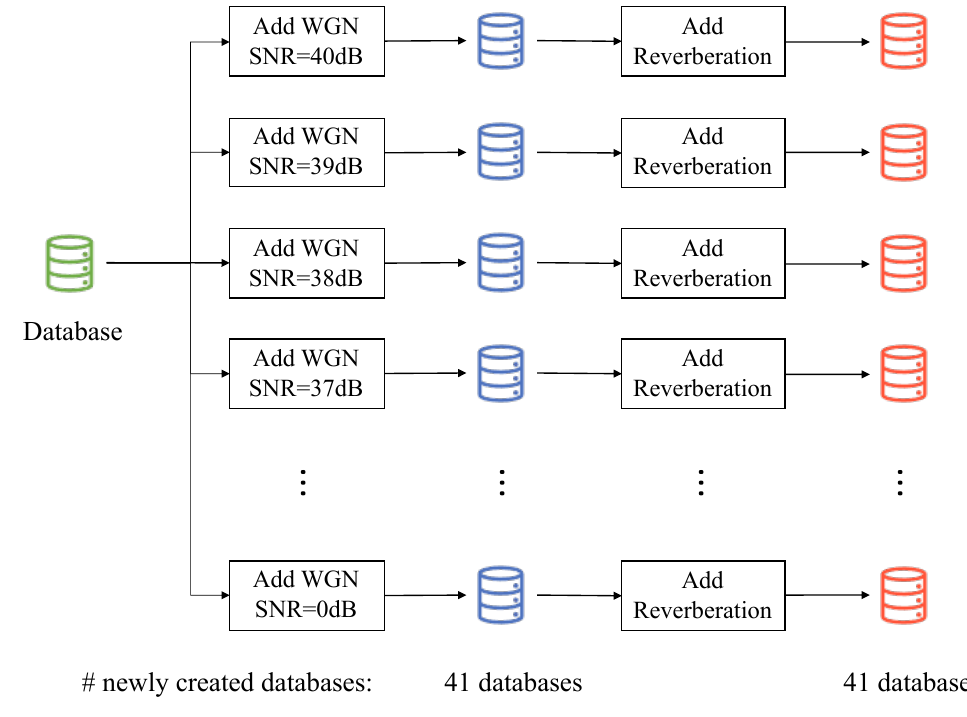
Figure 2. Creation of test sets diagram for one scenario. Table 2. Extracted features for the